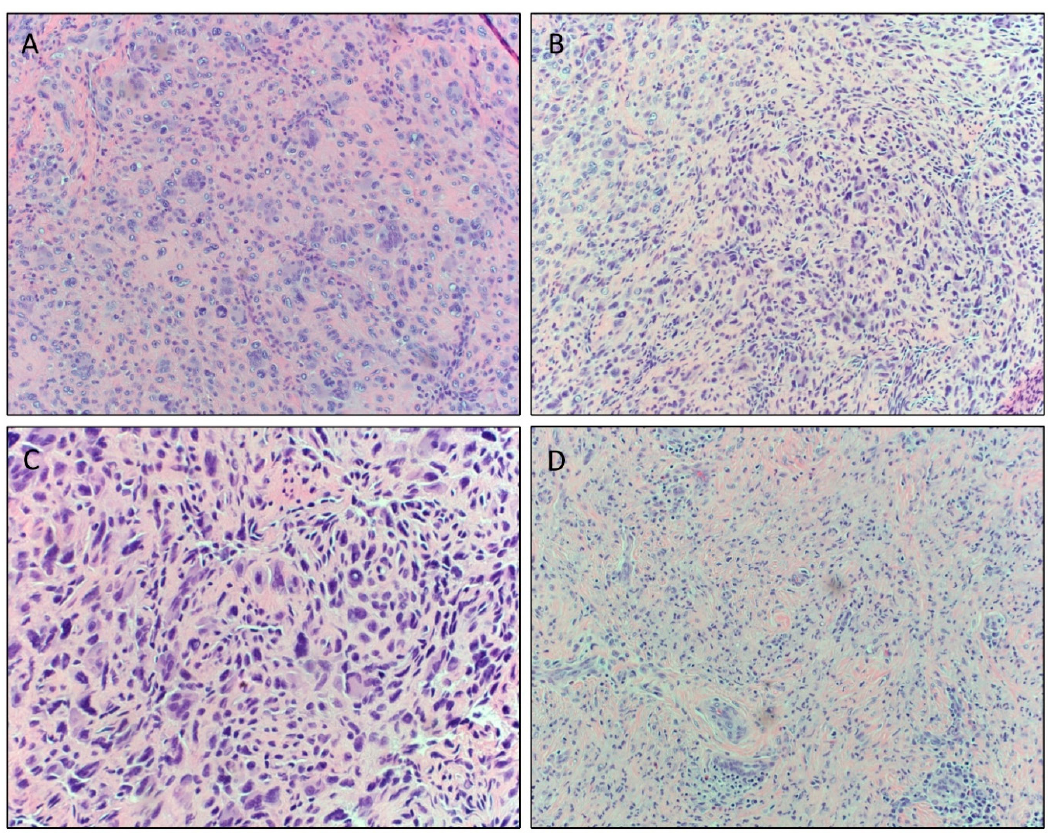
Figure 2. Spectrum of histomorphologic features of atypical tenosynovial giant cell tumors (TGCTs) in Case 2 ( A – C ) and Case 3 ( D – F ). ( A ) Mid-power magnification showing a cellular neoplasm with a predominance of mononucleated cells with scattered multinucleated osteoclast-like cells with intervening fibrous stroma (original magnification ×20). ( B ) Areas showing hyperchromatic pleomorphic nuclei and spindling. No necrosis was seen (original magnification ×40). ( C ) High-power magnification demonstrating multinucleated giant cells with symplastic changes in addition to increased cellular atypia in the mononuclear cell population consistent with the rendered diagnosis of atypical component within the tumor (original magnification ×40). ( D ) Photomicrograph of more benign-appearing areas composed of multinucleated giant cells and sheets of epithelioid histiocytoid cells arranged in a syncytial pattern (original magnification ×20). ( E ) Areas showing presence of larger pleomorphic nuclei with open chromatin and prominent nucleoli (original magnification ×40). ( F ) Scattered areas of cells with enlarged nuclei, spindle cells, and cells with virocyte-like nucleoli conferring worrisome morphology (original magnification ×40).